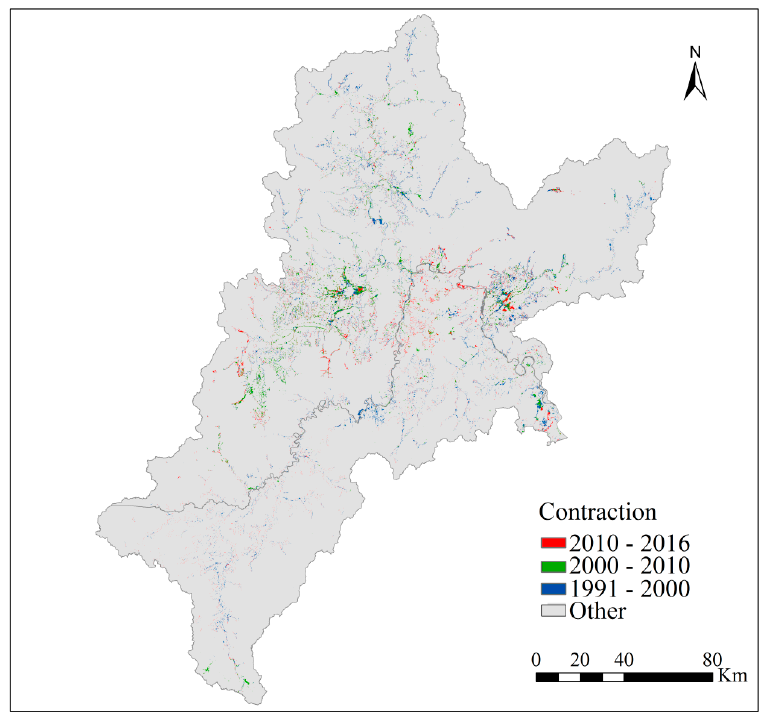
Figure 6. Spatial pattern of farmland contraction across different regions over the three times.